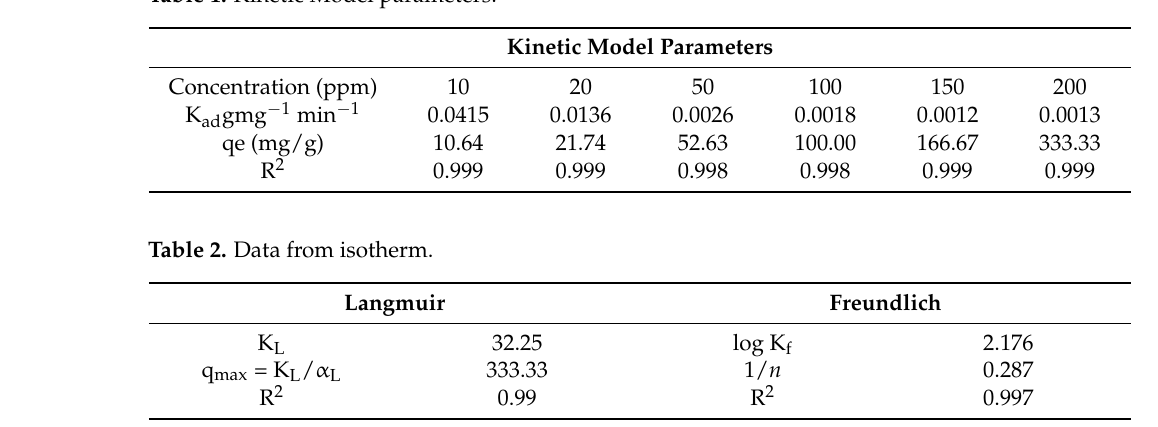
Table 1. Kinetic Model parameters.